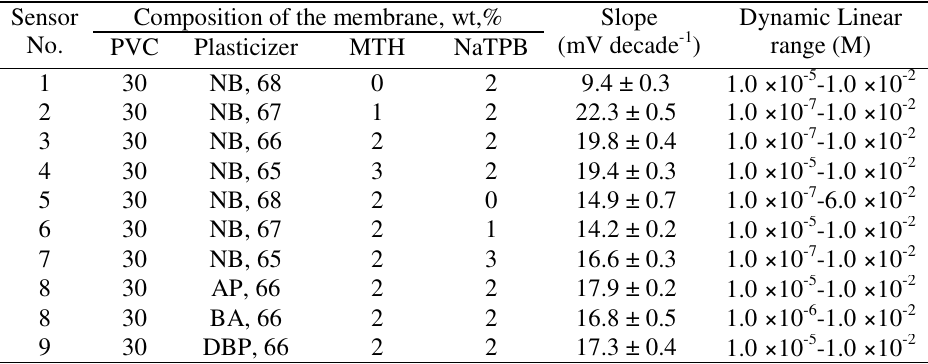
Table 1 . Optimization of the membrane ingredients